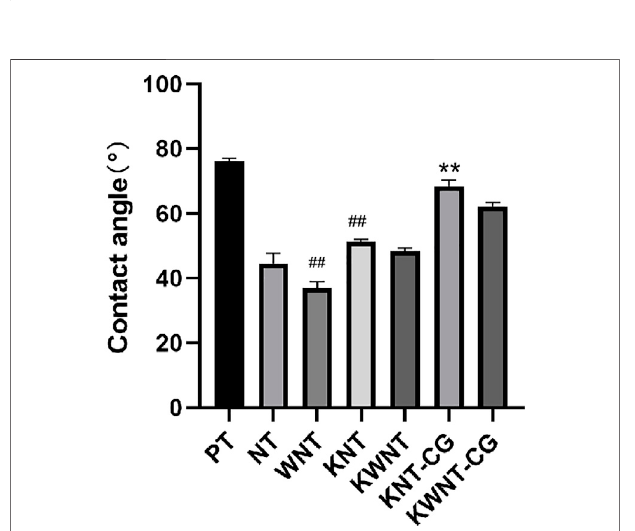
FIGURE3| Analysisoftheresultsofcontactanglecomparisonbetween groups. Bar graphs: Data are presented as mean ± SD. # represents comparison with NT group, ## p < 0.01; * represents comparison with PT group, ** p < 0.01.